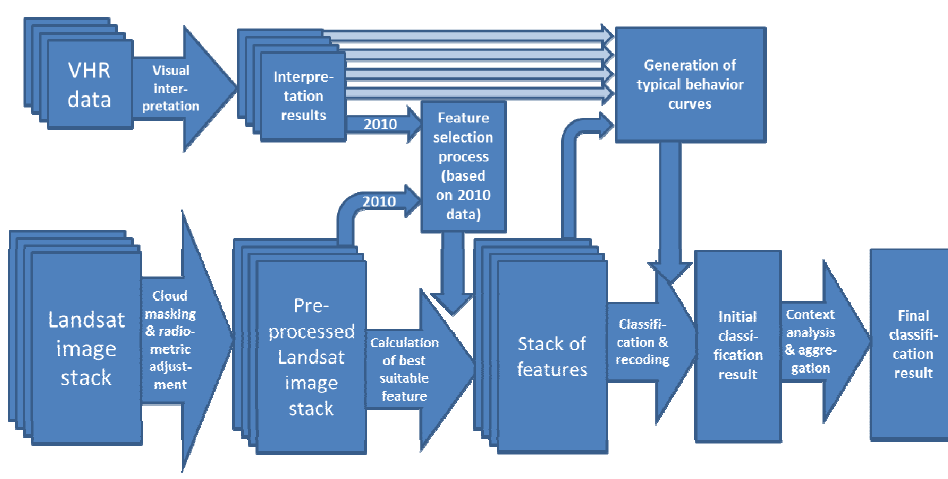
Figure 2. Overview of processing